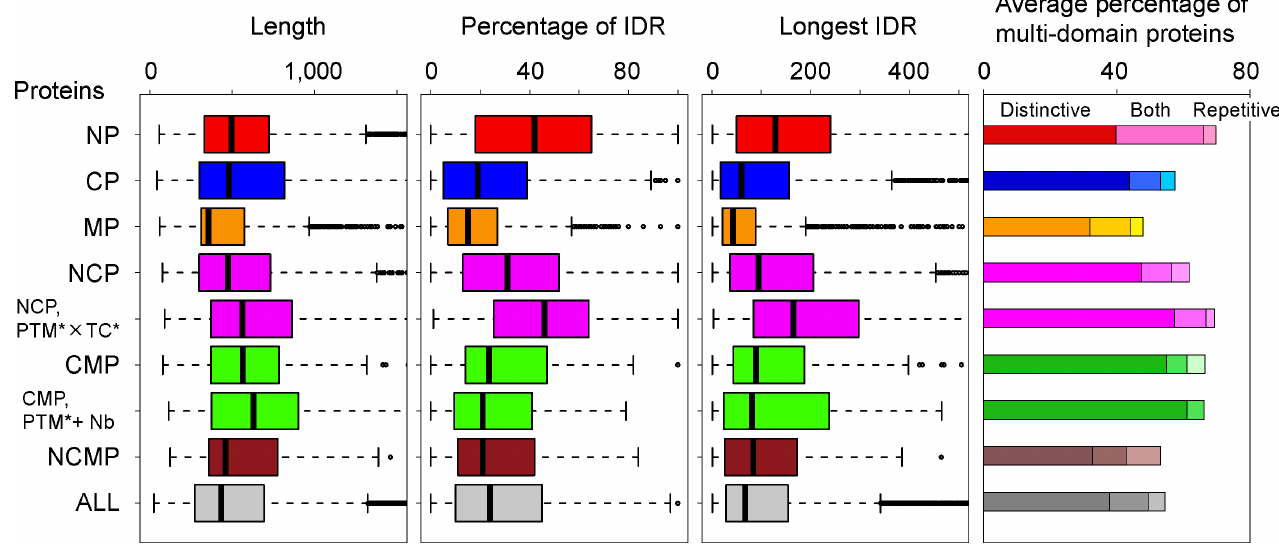
Fig 4. The protein structures characterized according to the intrinsic disorder and the domain architecture. From the left, the distributions of protein length, percentage of IDR, and longest IDR length are shown (see full size view in S3 Fig). The average percentage of multi-domain proteins is presented in the right panel, where the proteins were divided into those composed of only distinctive multi-domains (D), distinctive and repetitive multi-domains (B), and only repetitive multi-domains (R). The compositions are represented by the brightness of the colors. TC * and Nb are the abbreviations of transcription * and